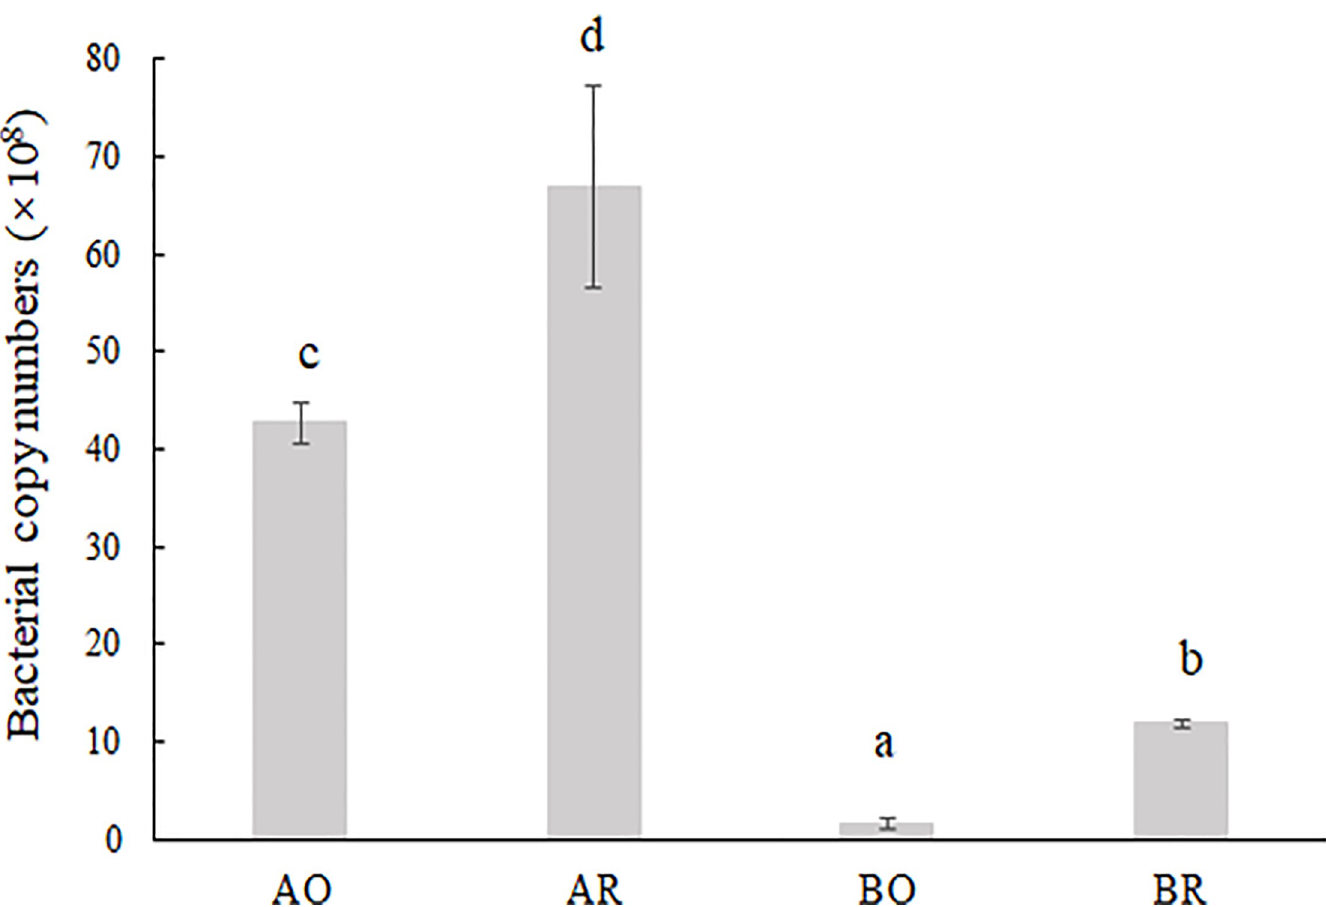
Fig 1. Abundances of bacteria, as indicated by the number of 16S rDNA copies measured by quantitative PCR.